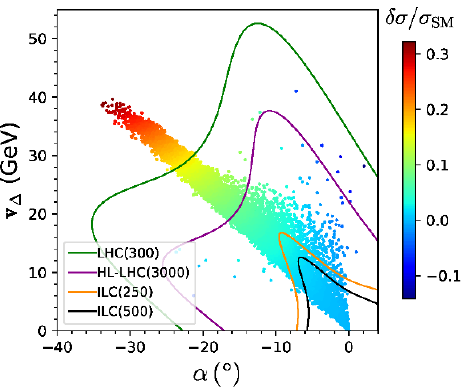
Figure 9 . Distribution of relative corrections (cid:14)(cid:27)=(cid:27) (cid:0) (cid:11) plane for HS and VBF processes. SM in the v (cid:1) LHC@300 will mostly exclude (cid:20) hV V & 1 : 1, while HL-LHC@3000 could probe down to (cid:20) hV V & 1 : 05. The scale factor (cid:20) hV V is expected to be measured at future e + e (cid:0)